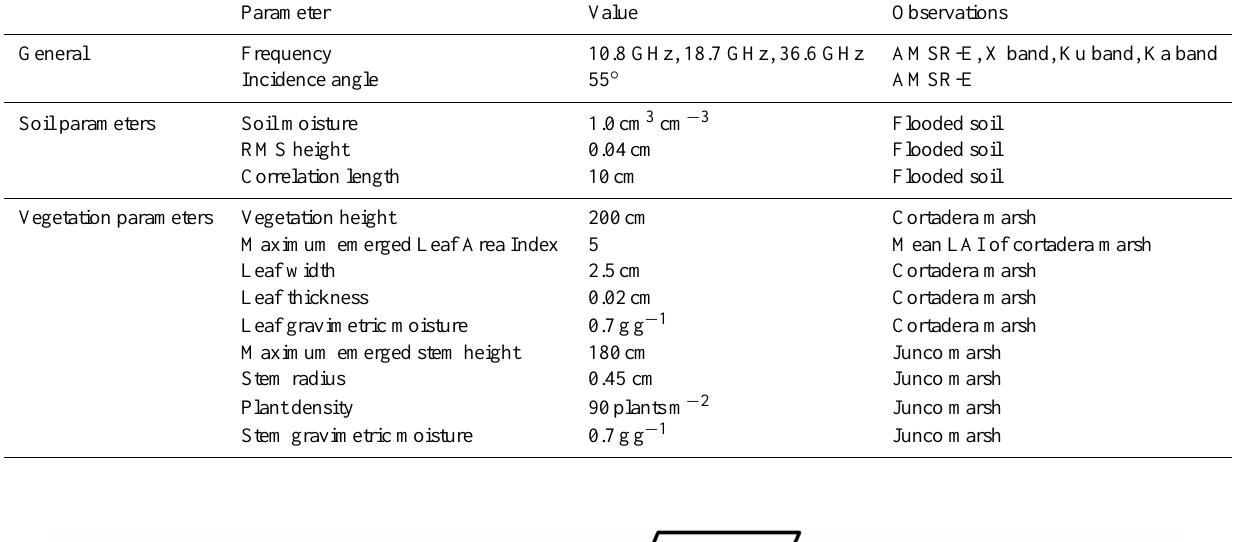
Table 2. Input parameters to the interaction model.